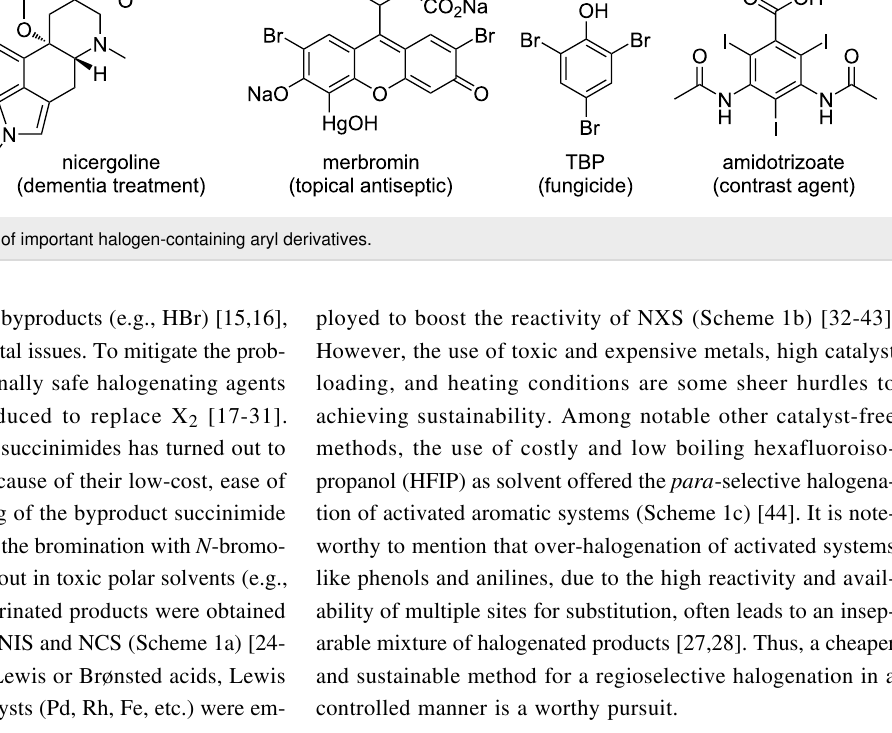
Figure 1: Representative examples of important halogen-containing aryl derivatives.